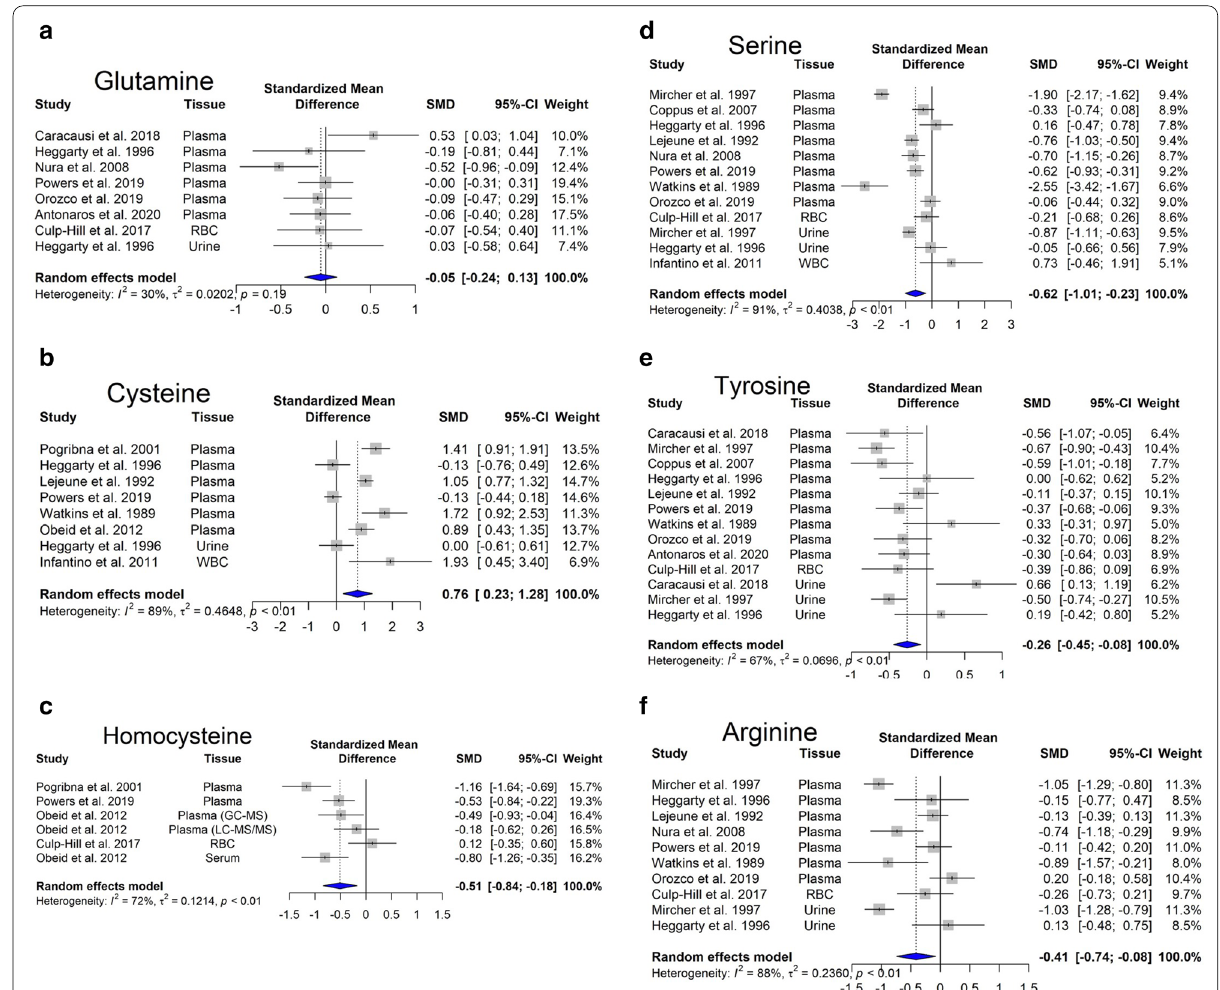
Fig. 5 Changes in selected amino acids in Down syndrome. Forest plot showing relative weights, standardized mean difference (Hedges’ g) with confidence intervals. Overall average effect size is displayed by filled